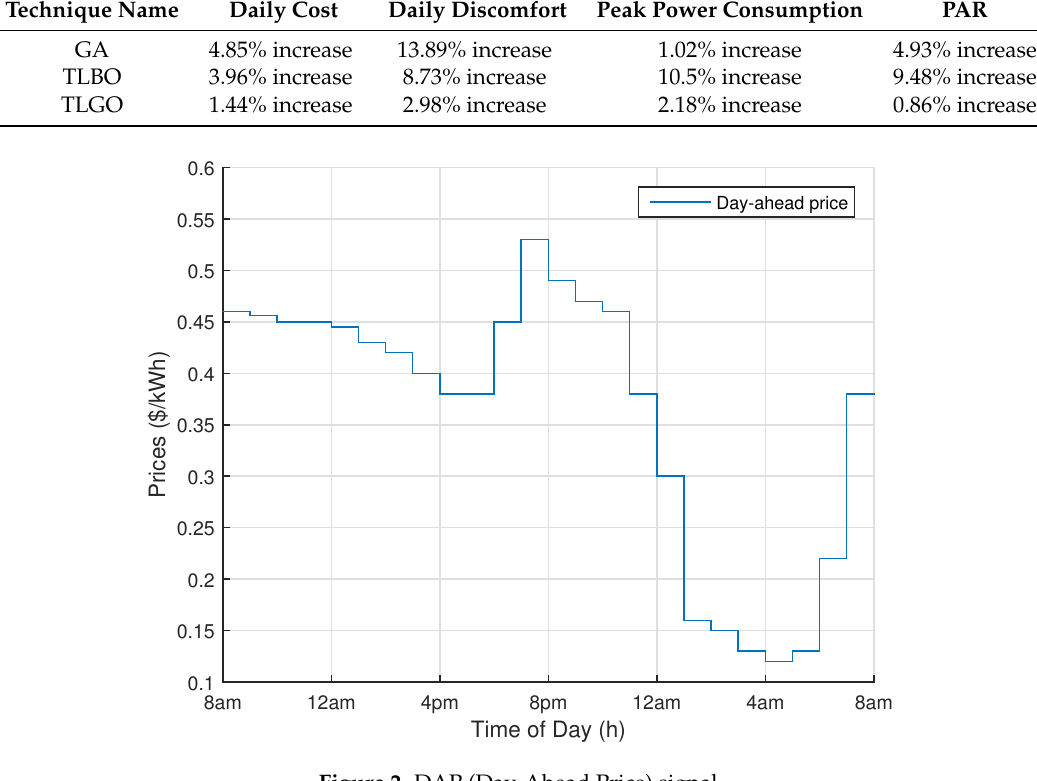
Figure 2. DAP (Day-Ahead Price)